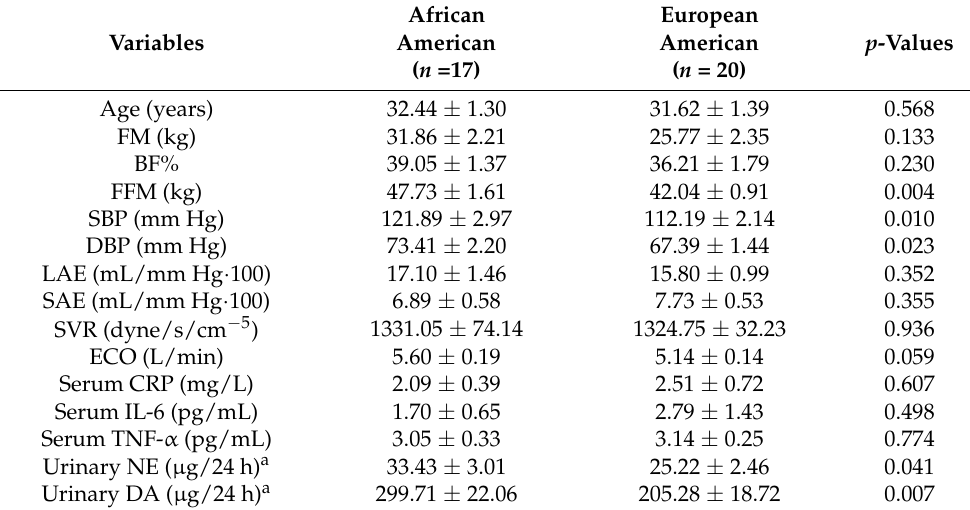
Table 1. Descriptive statistics of study participants according to race. Variables